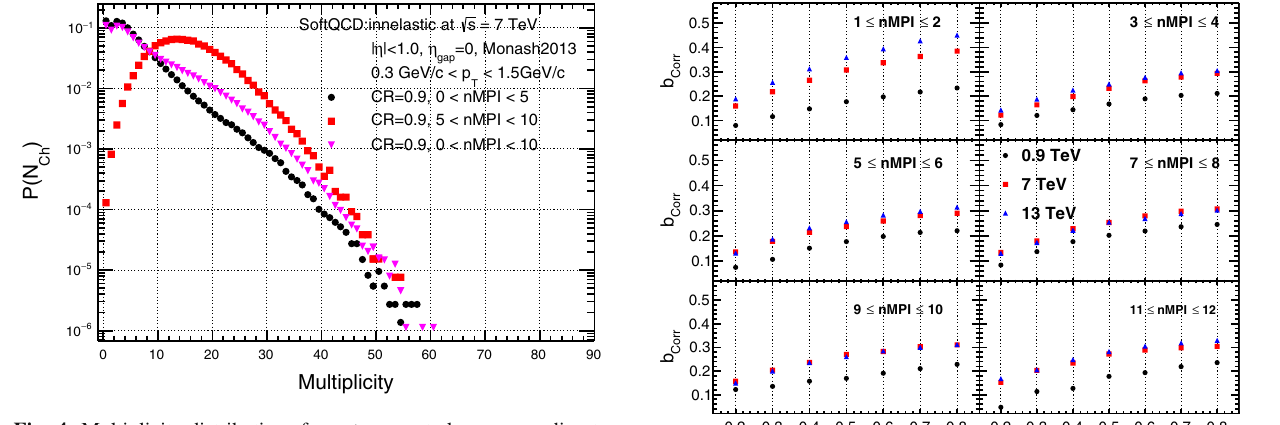
Fig. 5 Number of MPI distributions for p + p collisions at 0 . 9 , 7 , 13 and 18 TeV